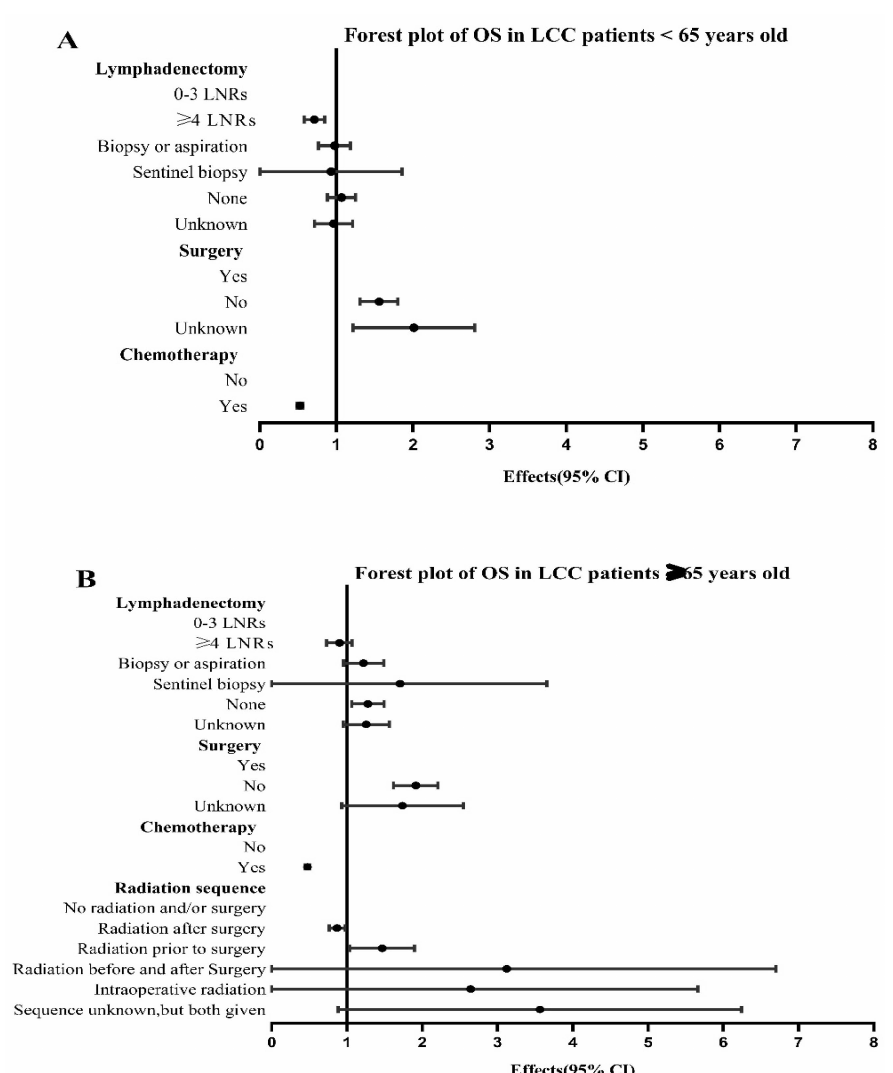
Figure 5. Forest plots of variables that can influence OS in LCC patients <65 years old and ≥ 65 years old. ( A ) Comparison of OS in LCC patients <65 years old; ( B ) Comparison of OS in LCC patients ≥ 65 years old. Abbreviations: LCC: large cell carcinoma; CI: confidence interval; OS: Overall survival; LNRs: lymph nodes